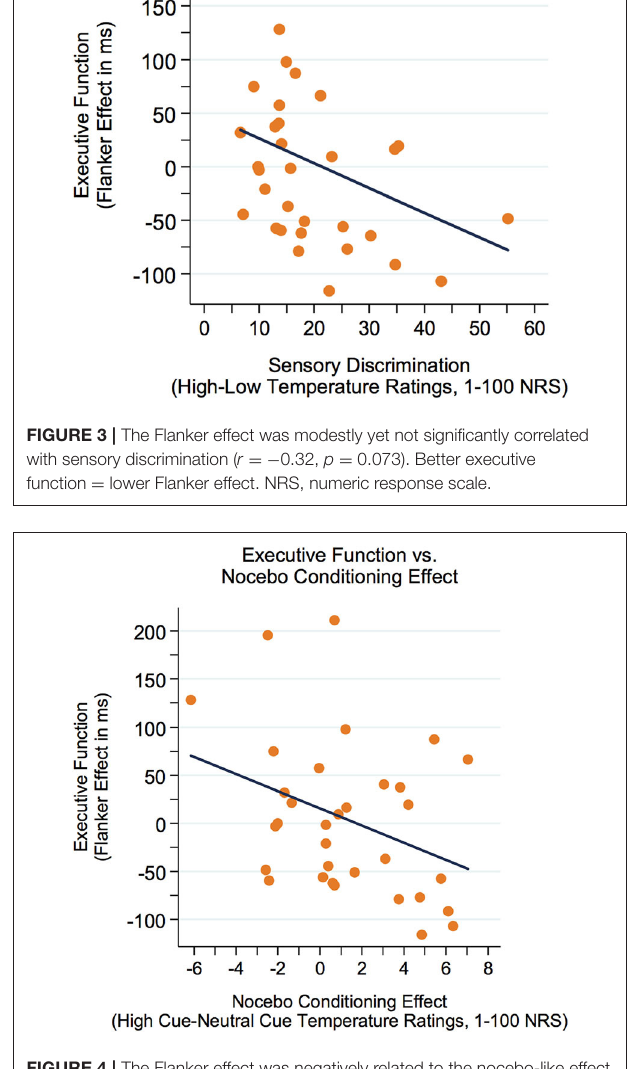
(direct effect c’) when the mediator (Flanker effect) was